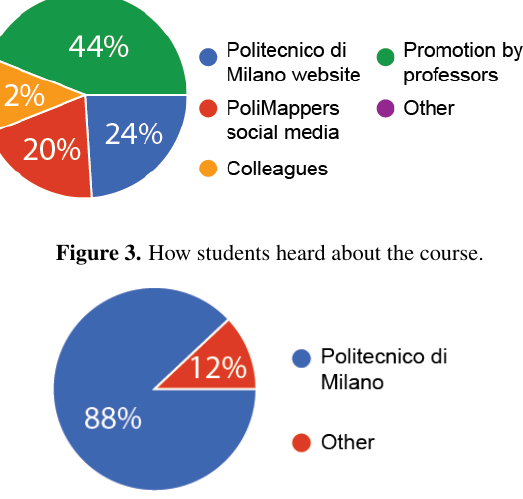
Figure 4. Percentage of students enrolled at Politecnico di Milano.